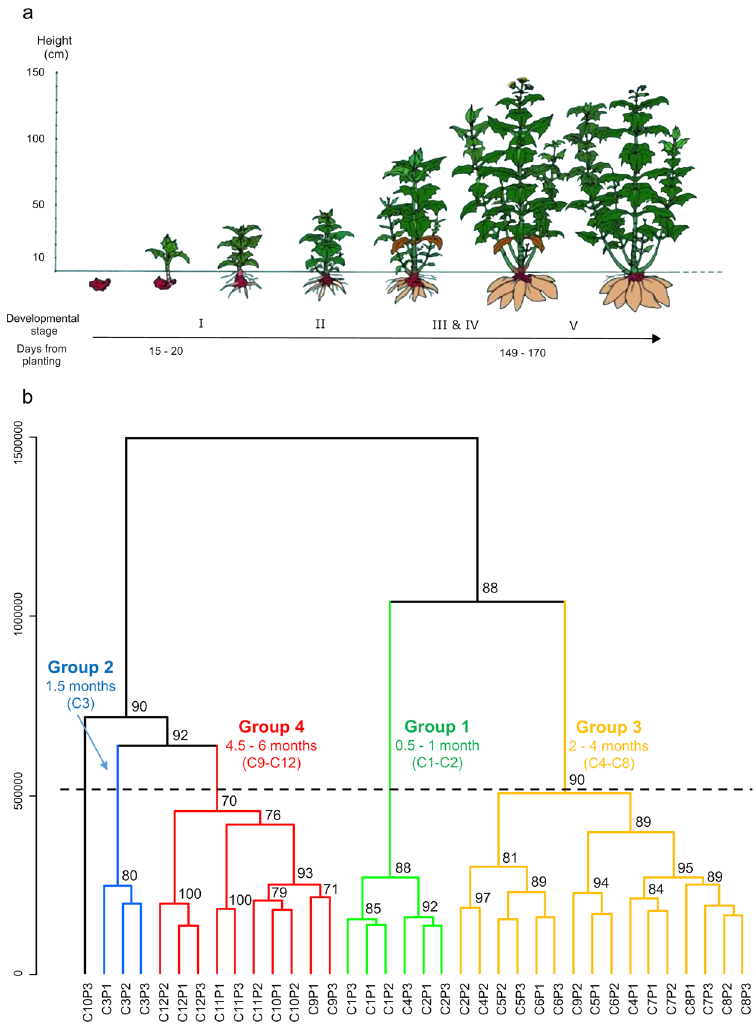
Figure 2. ( a ) Graphical representation of the developmental stages of yacón (image by Prof. Dr. Eloy Fernandez, Czech University of Life Sciences) and ( b ) HCAbp based on metabolic fingerprinting by UHPLC- UV-HRMS in positive mode of 36 extracts from Smallanthus sonchifolius leaves collected along the development of the plant (C1 to C12). Proposed groups of samples with similar metabolic fingerprints are highlighted in different